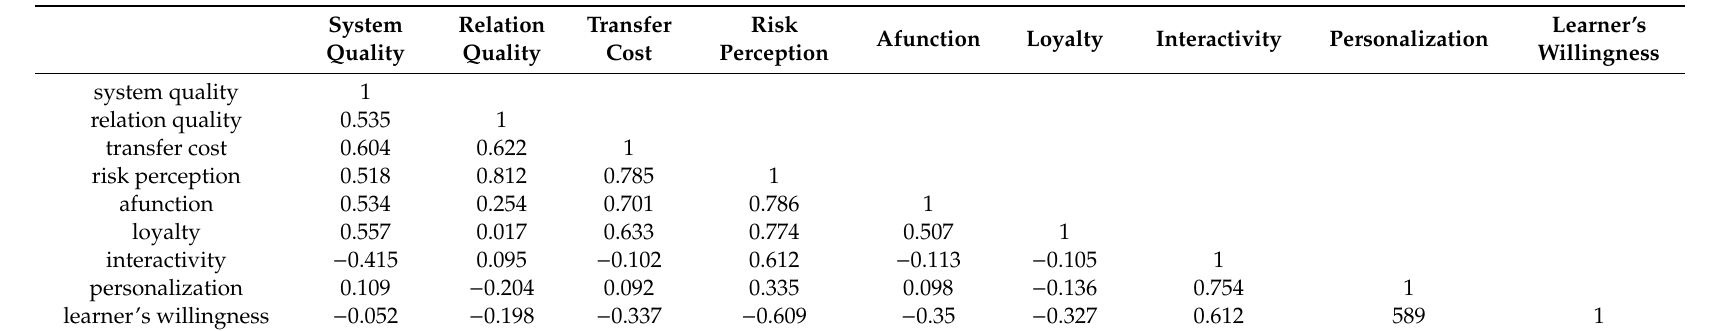
Table 2. Heterotrait-monotrait ratio of